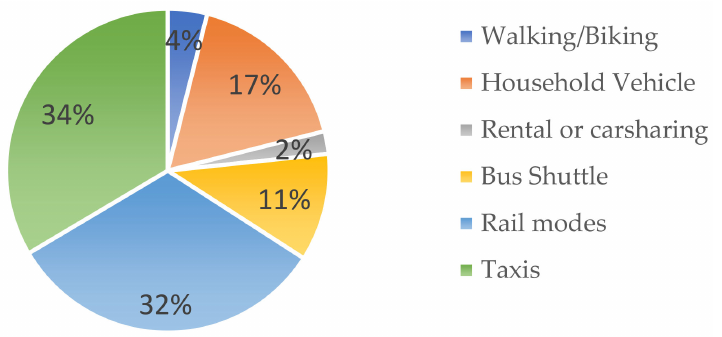
Figure 3. The percentage of modal shift to ridesourcing services. The results indicate that the most replaced mobility modes by ridesourcing services, including Uber, Lyft, Via, and Juno are taxis and rail modes by 34%, 32%, respectively. The private car is in the third place by 17%. The Kruskal-Wallis test is used to study whether there is a significant difference in the distribution of annual household incomes among citizens who replaced different mobility modes with ridesourcing services. Figure 4 illustrated the boxplot of annual household incomes per each replaced mobility mode by